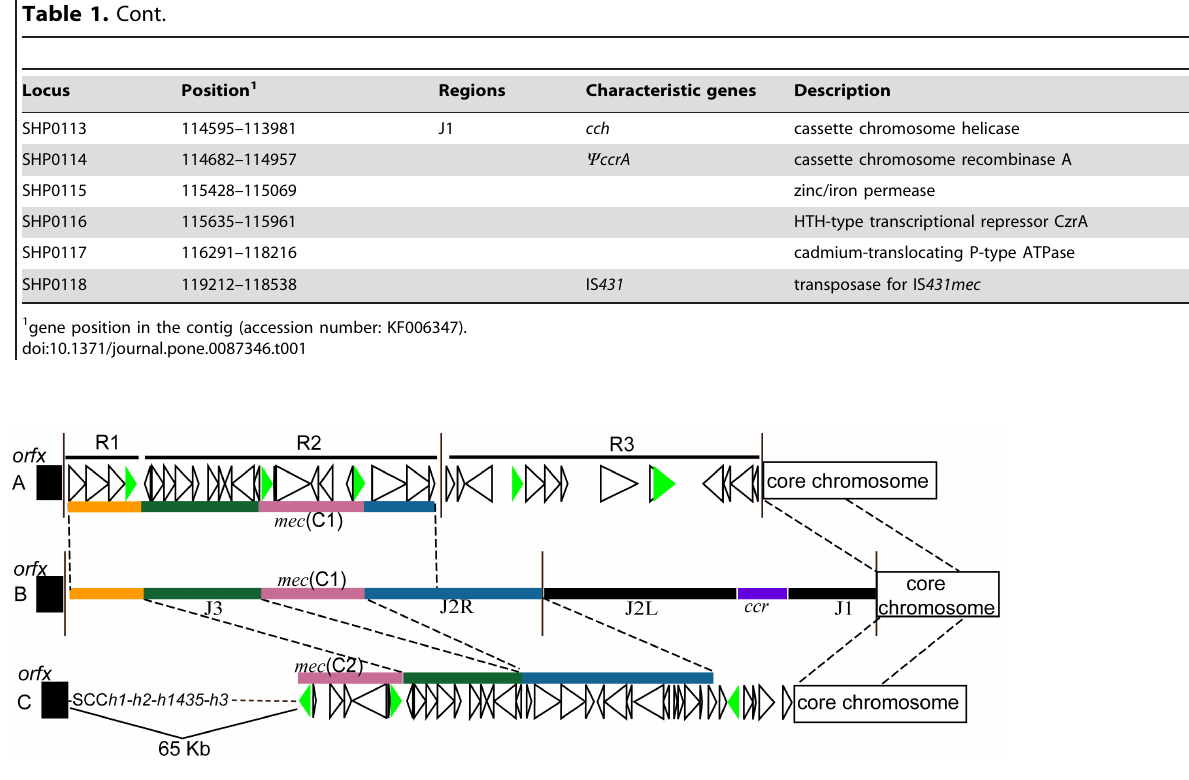
Figure 2. Comparison of SCC mec elements in three Staphylococcushaemolyticus isolates. A: WCH1; B: SH32; C: JCSC 1435. mec (C1/C2): class C1/C2 mec complex. Rectangles with the same colors denote homologous regions. Dashed lines indicate their ends. Vertical solid lines indicate the site of integration site sequences. Green triangles denote insertion sequences.